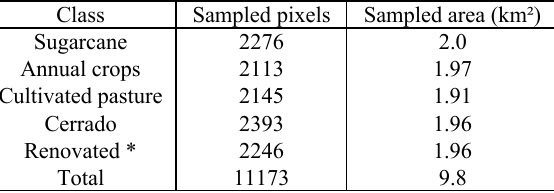
Table 1 . Number of sampled pixels and corresponding sampled area, per class. *Renovated surgarcane fields.